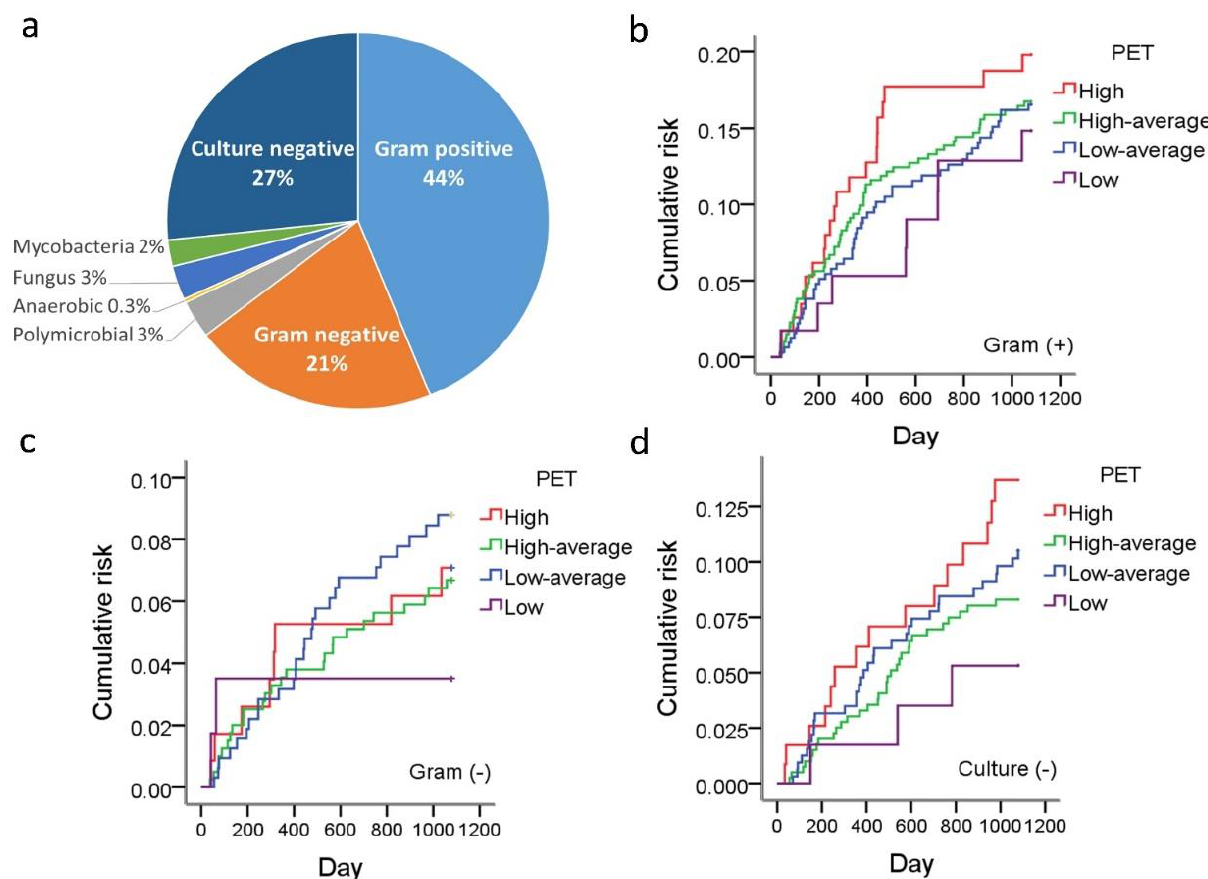
Figure 3. Subgroup analysis of peritonitis rates in different microbial etiologies. The percentage of different microbial etiologies is illustrated in panel ( a ). The peritonitis rates of the four transport statuses regarding different pathogenic microorganisms are illustrated as Gram-positive bacilli ( b